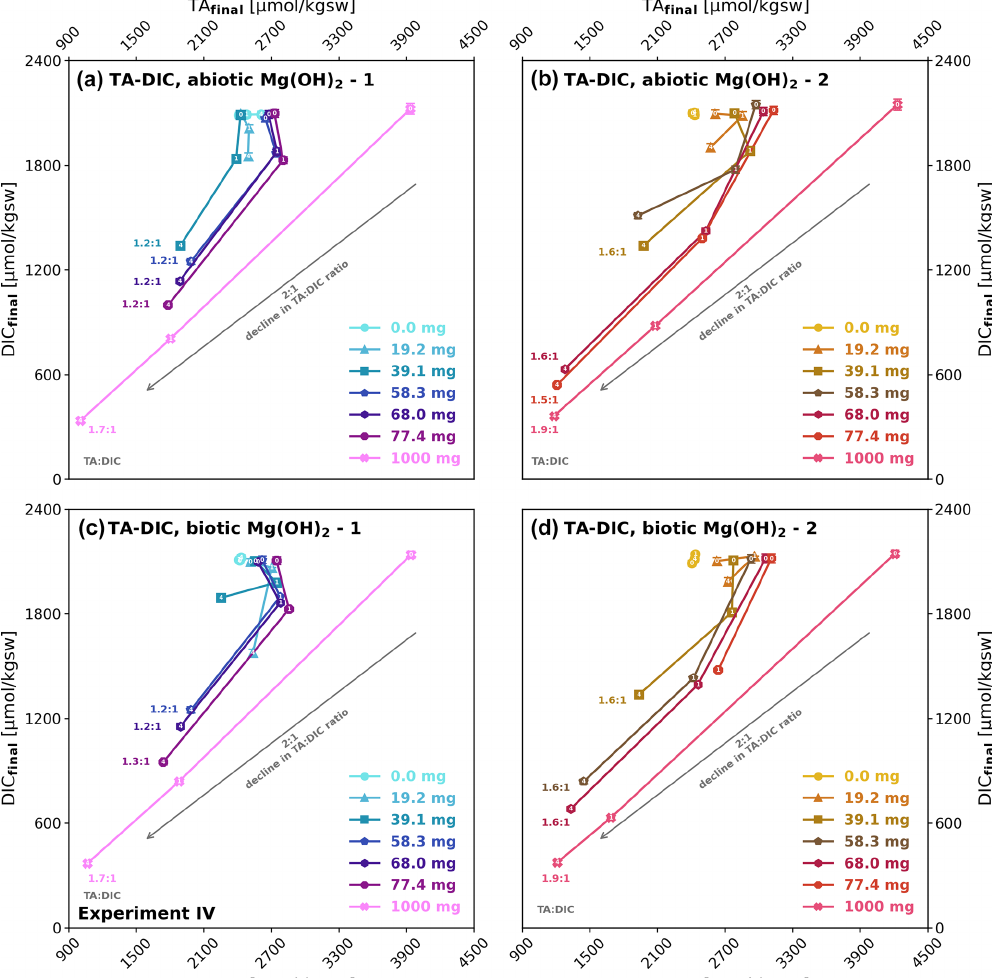
Figure 6. Development of TA final versus DIC final during brucite dissolution in experiment IV: (a, b) abiotic after 0, 1, and 4d and (c, d) biotic after 0 and 4d. The days of sampling (0, 1, and 4) are written on top of each data point marker. TA:DIC change ratios for brucite I (1 . 2 : 1) and brucite II (1 . 6 : 1) are indicating simultaneous precipitation and dissolution, while their difference could be described by their differing dissolution characteristics. The grey arrows indicate an ideal 2 : 1 decline in